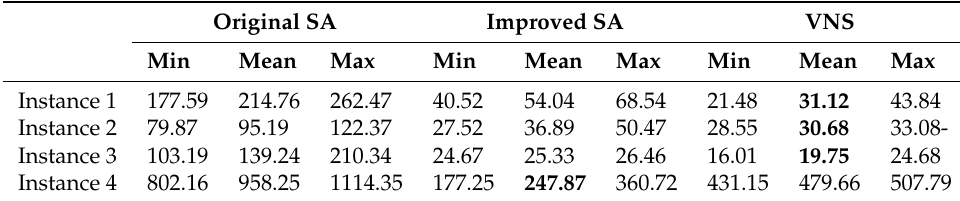
Table 8. Computation times (in minutes) in Phase 3.